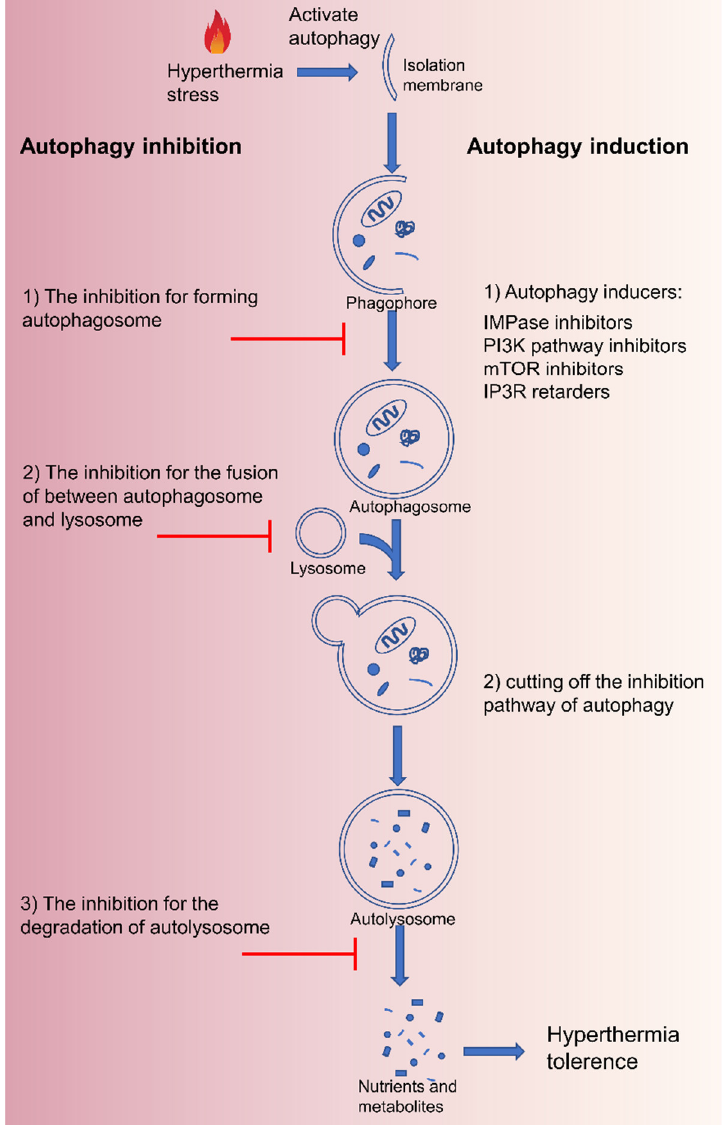
Figure 3. Schematic of the process of macroautophagy after hyperthermia and the various strategies to inhibit or induce autophagy.